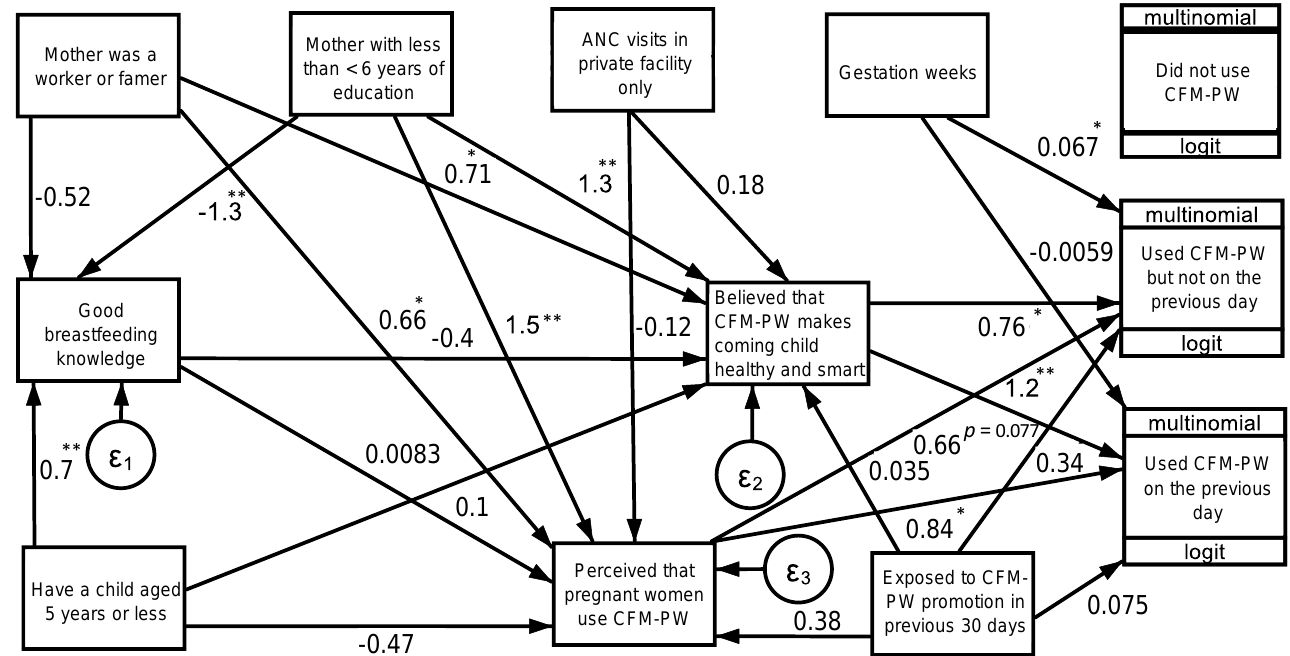
Figure 1. Structural equation modeling (SEM) analysis for association among beliefs and social norms and use of commercial milk for pregnant women (CMF-PW). Boxes indicate measured variables; arrows indicate direction of association; and values are coefficient, n = 268. * p < 0.05, ** p < 0.01, other p < 0.10 were indicated by exact value.